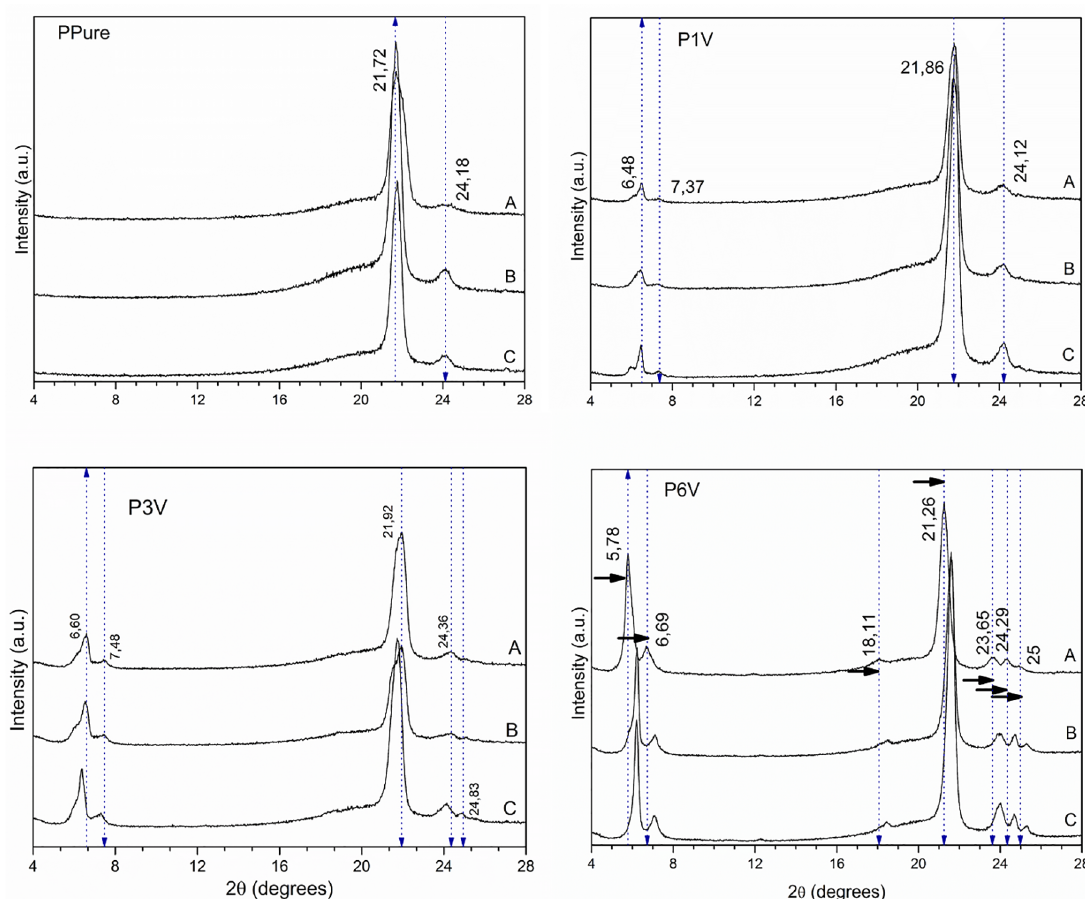
in the time of 10 min (B) and 20 min 2